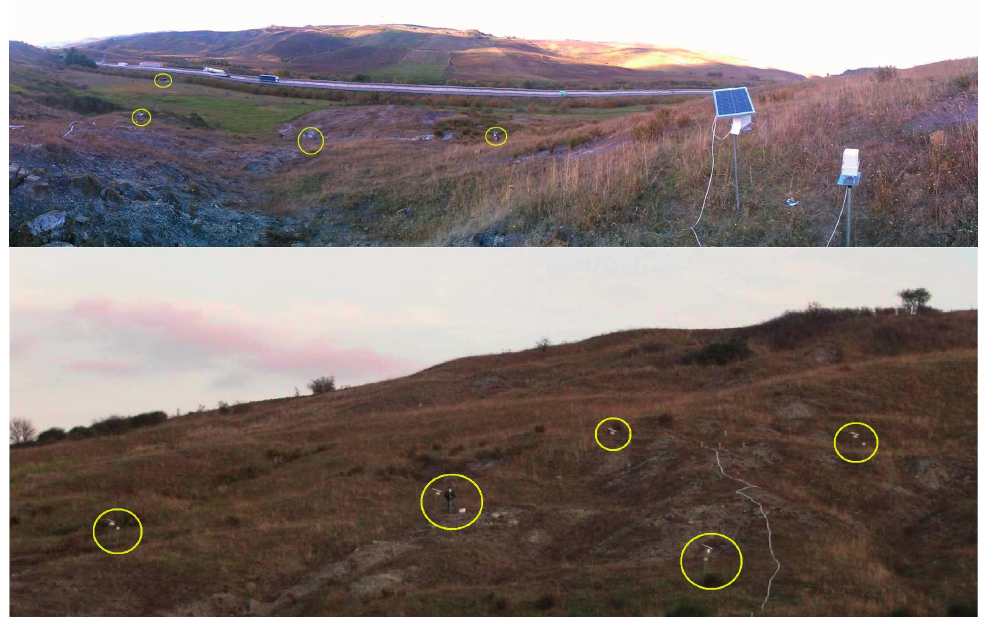
Figure 14. ( Top ) A partial view of the sensor network installed near the highway A16. The sensors are circled; the upper left sensor, out of the accumulation zone of the landslide, acts as the coordinator node; ( Bottom ) The sensor network seen from below. The cable on the right, powers a group of MEMS sensors installed in the same